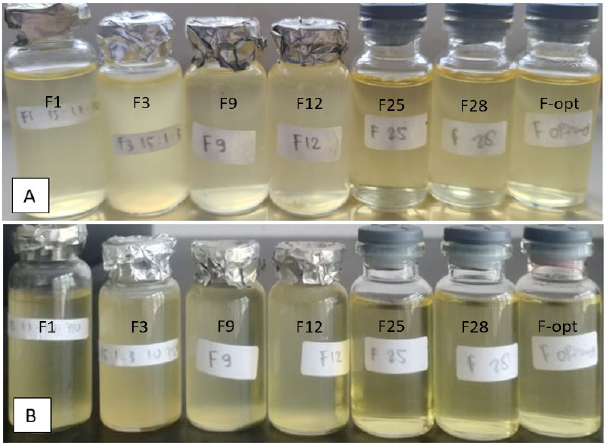
Figure 3. Physical observation of 6 USUC base formulae and the optimal base formula ( A ) before and ( B ) after 8 week storage at room temperature.